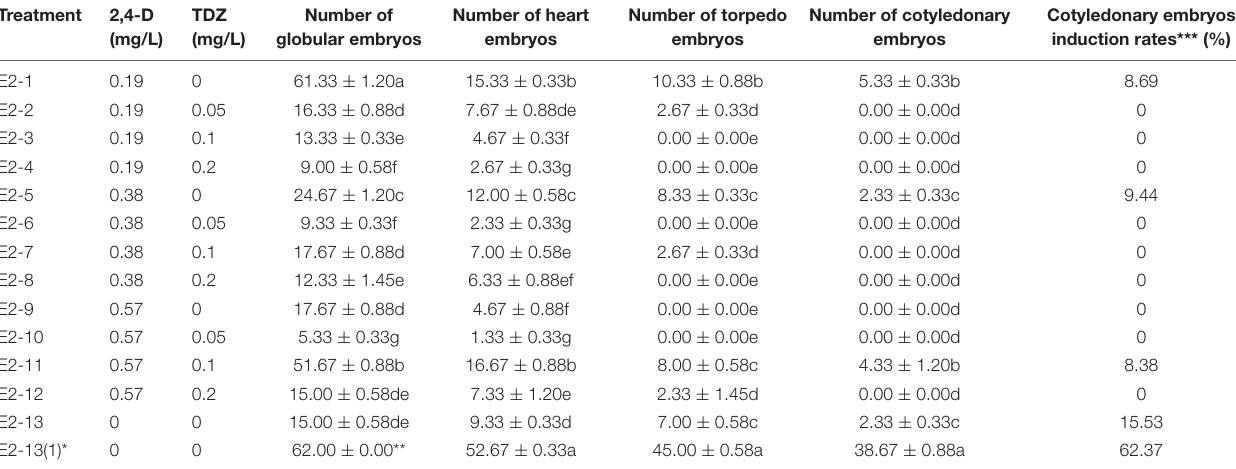
TABLE 3 | Indirect somatic embryogenesis and differentiation rates of embryogenic callus with the combination of 2,4-D and TDZ in C. oleifera . Treatment 2,4-D Number of Number of heart Number of torpedo Number of cotyledonary Cotyledonary embryos (mg/L) globular embryos embryos embryos embryos induction rates*** (%)